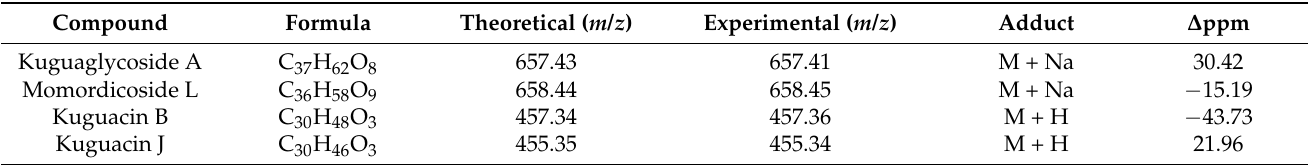
Table 3. Cucurbitane-type triterpenoids identified in M. charantia extracts by LC/MS. Compound Formula Theoretical ( m / z